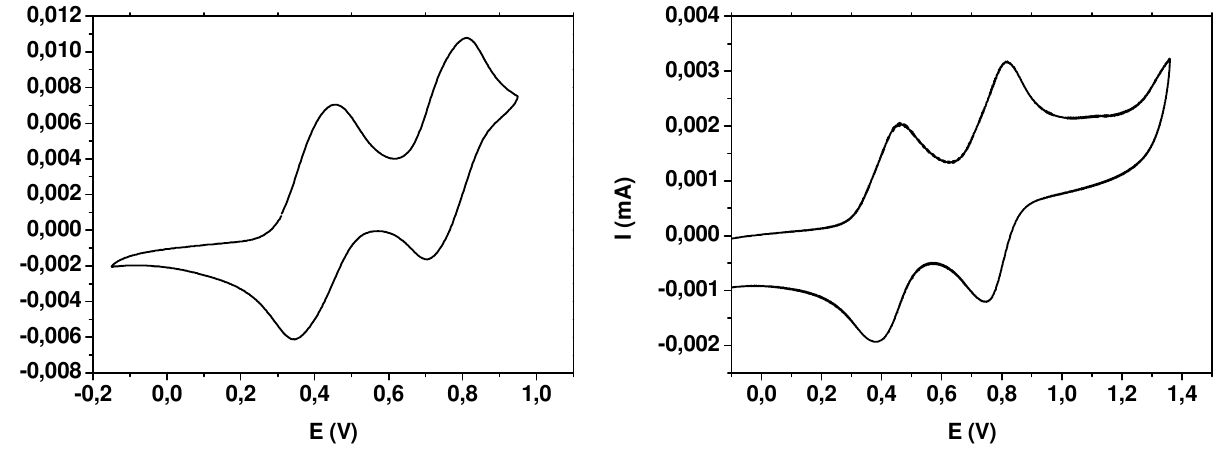
CN with n Bu NPF (0.1 3 4 6